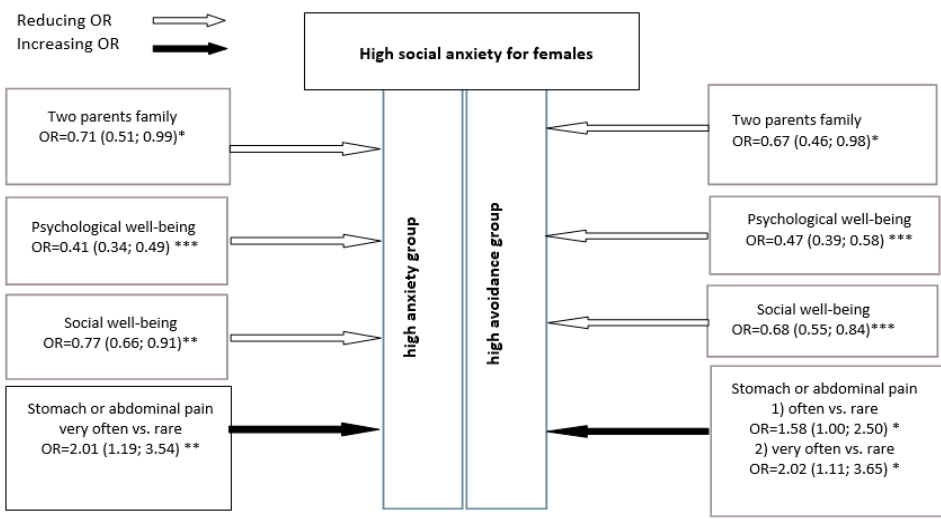
Figure 1. Multivariate logistic regression model for females: opportunity ratio (95% CI) to be high on SA in context of independent variables (* p < 0.05; ** p < 0.01; *** p < 0.001).